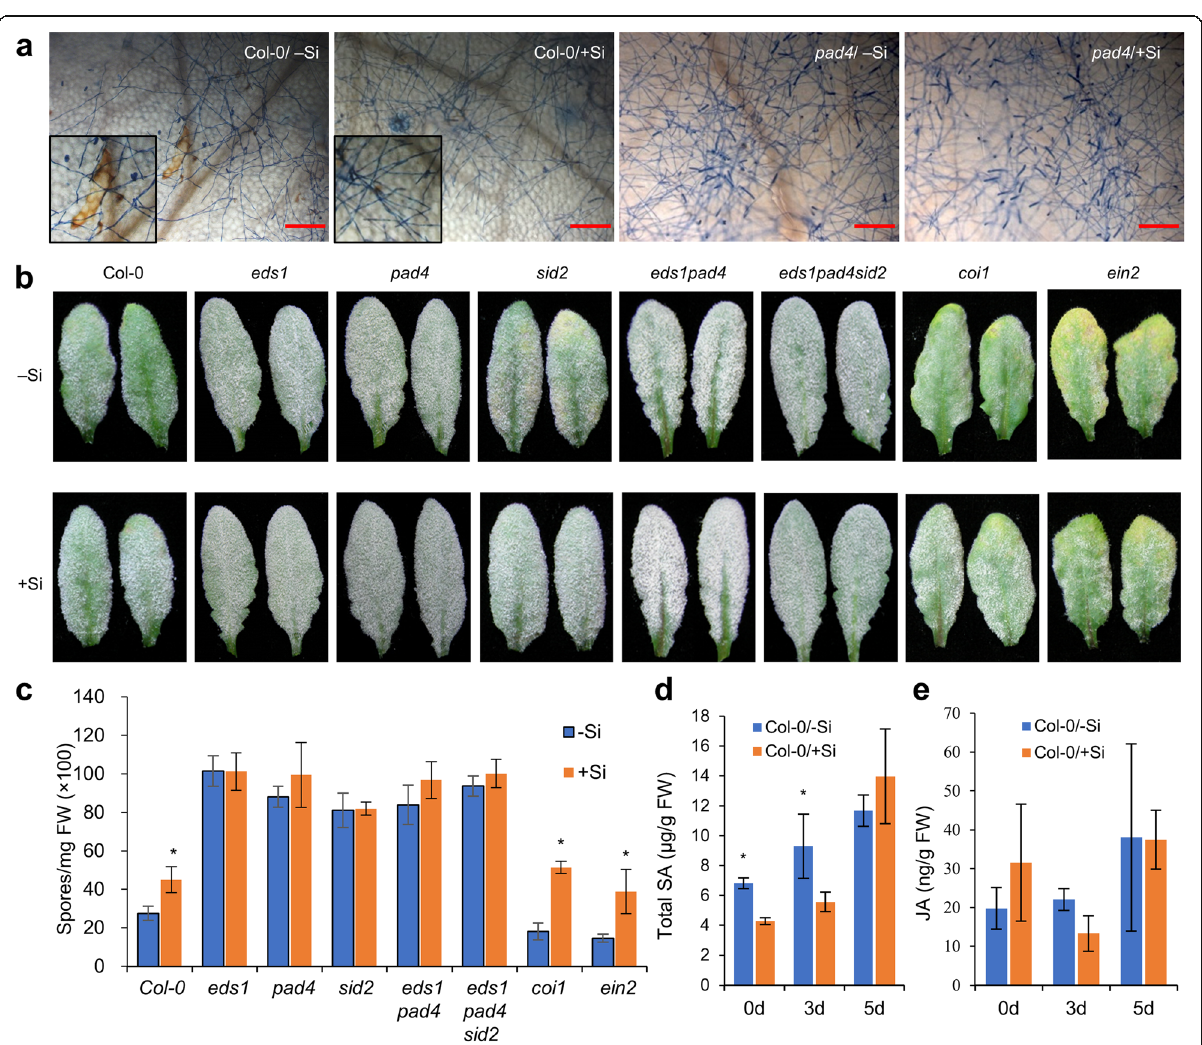
Fig. 3 Very low Si-conditioned powdery mildew resistance requires SA-pathway components EDS1, PAD4 and SID2. a Representative microscopic images showing growth of Gc UCSC1 at 5 dpi on leaves of Col-0 or pad4 – 1 plants grown in perlite supplemented with 0mM ( − Si) or 1.0mM (+Si) Si. Fungal structures were stained blue by trypan blue, while production and accumulation of H 2 O 2 by the host was visualized as reddish-brown stain (highlighted in the insets) upon reaction with 3,3-diaminobenzidine. Scale bars=200 μ m. b Representative Gc UCSC1-infected leaves of plants from the indicated genotypes grown in perlite supplemented with 0mM ( − Si) or 1.0mM (+Si) Si. Pictures were taken at 10 dpi. c Quantification of spore production at 10 dpi in plants of the indicated genotypes in (b). d, e Total SA and JA levels in Gc UCSC1-infected leaves of wild-type Col-0 plants grown in perlite supplemented with 0mM ( − Si) or 1.0mM (+Si) Si. Leaf samples were collected and analyzed at 0, 3 and 5 dpi. Error bar indicates SE based on 4 replicates, and asterisks denote significant difference (Student t -test, * P